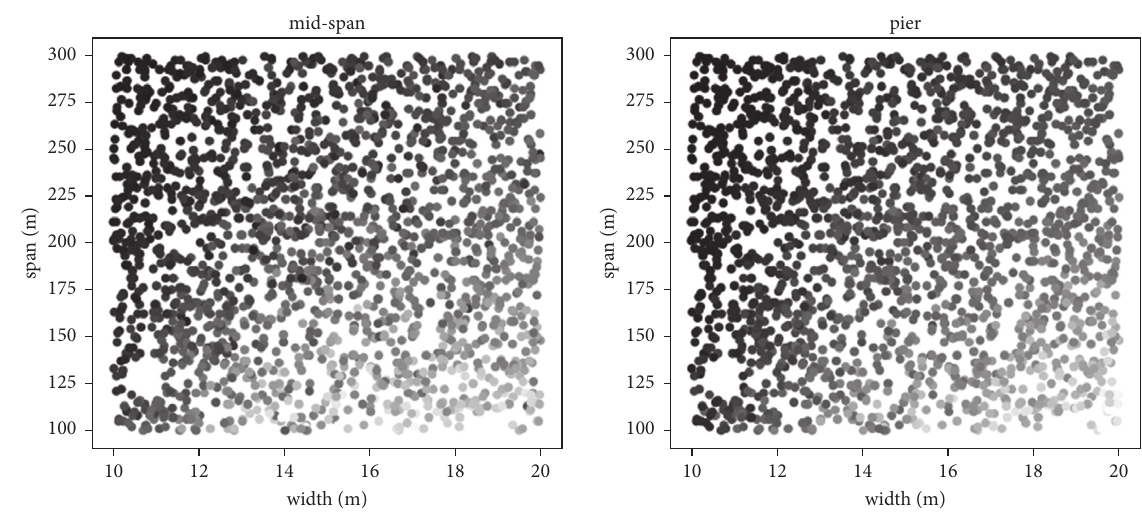
Figure 3: Scatters of effective width coefficients at different